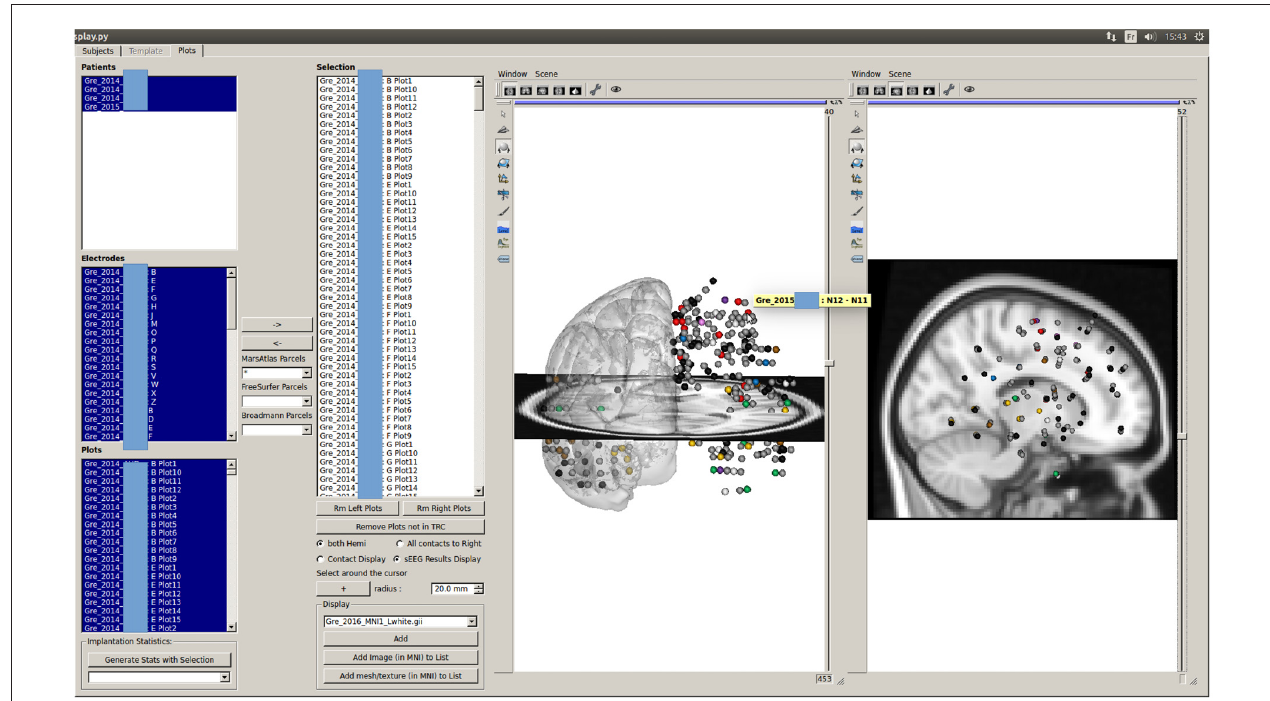
FIGURE 11 | Stimulation results of multiple patients displayed on the glass brain: similarly to the patient visualization in Figure 7 , the stimulation results are shown as color-coded spheres. Color code is: gray—bipole not stimulated; black—stimulated but no response; red—motor sensation; blue—sensitive sensation; green—sensory sensation; yellow—vegetative sensation; purple—emotional sensation; pink—experiential sensation; brown—superior function sensation; white—multiple